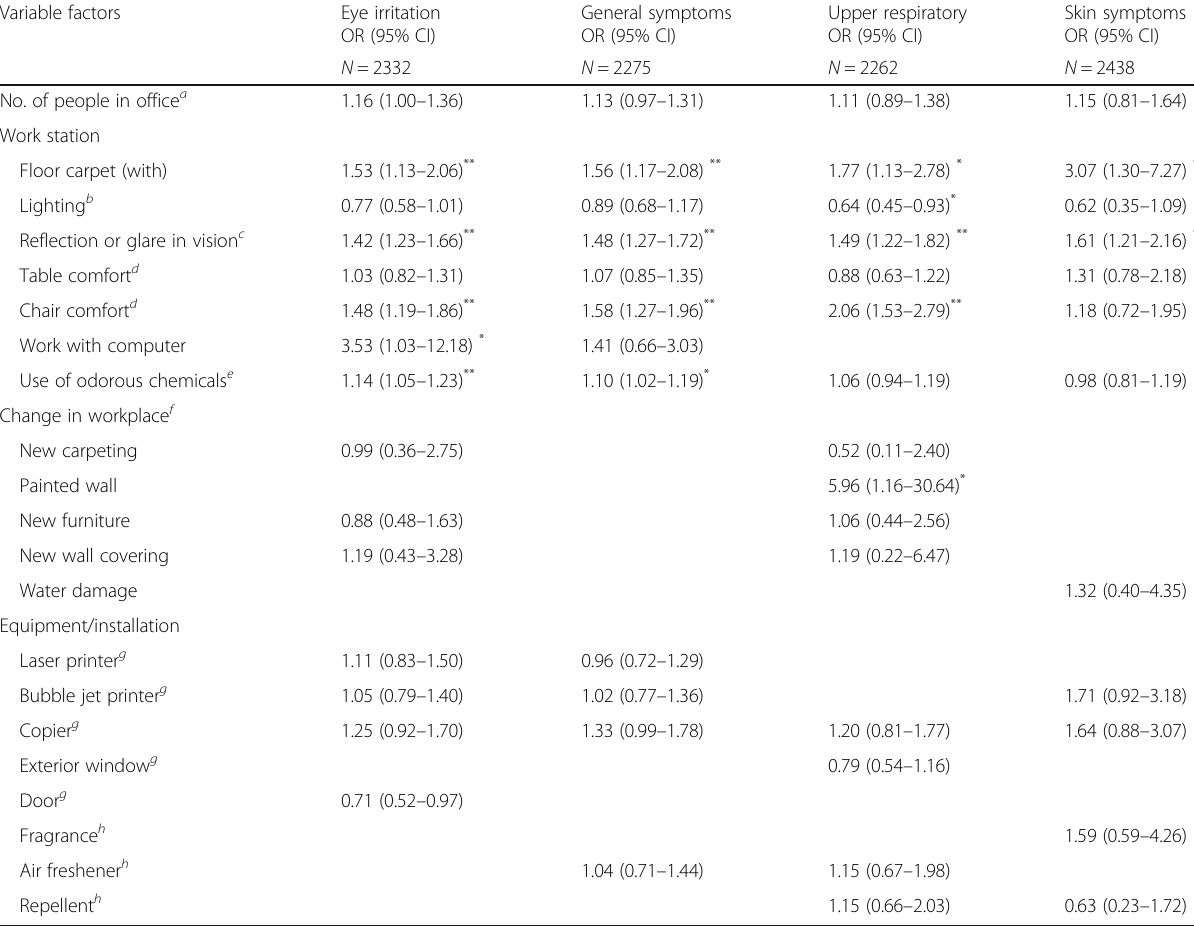
Table 4 Associations between weekly building-related symptoms and the work environment (Model 2) Variable